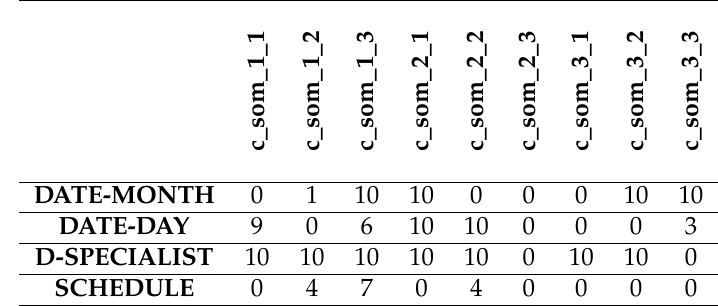
Table 3: Direct Characteristics